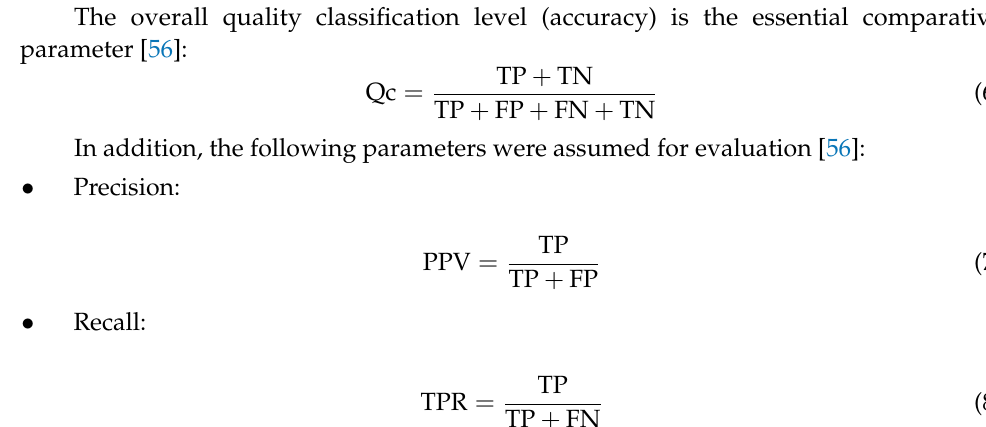
Table 1. Confusion matrix for a binary classification. Actual Positive Actual Negative Predicted positive True positives TP False positives FP Predicted negative False negatives FN True negatives